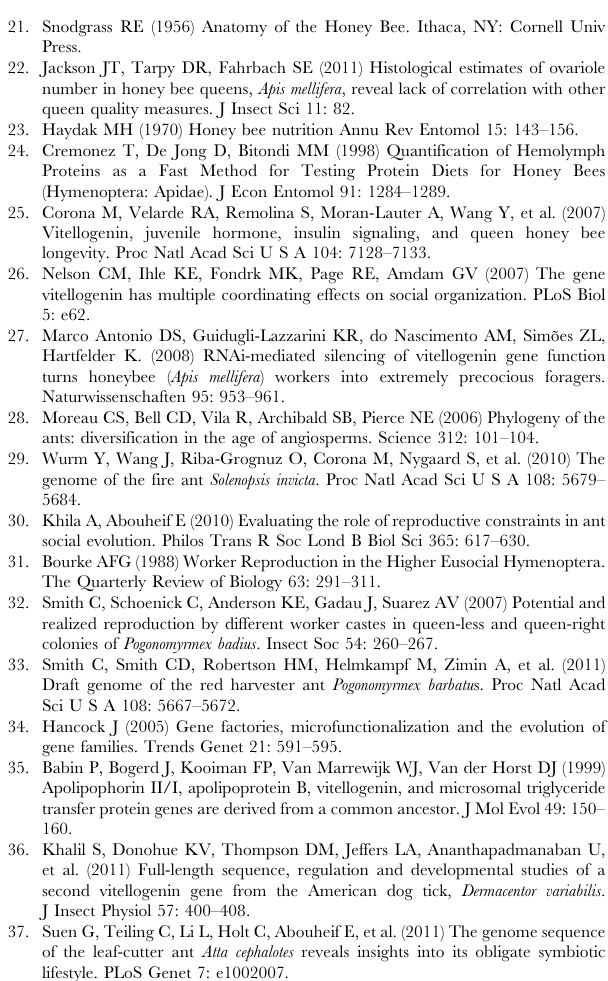
Figure S1 Relative mRNA levels of Pb_Vg1 and Pb_Vg2 in queens, nurses, and foragers. Experiments were performed in five